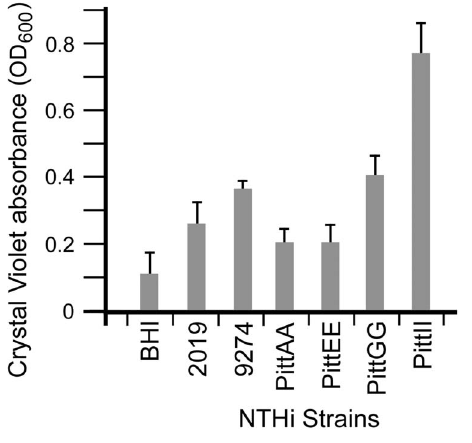
Figure 1. Biofilm formation is variable between NTHi strains. Biofilm quantification using crystal violet assay showed the variability in biofilm formation between the NTHi strains in this study. Relative Biofilm Quantity was measured as OD 600 of crystal violet in DMSO; higher absorbance indicated more biofilm production. The PittAA and PittEE strains showed the least amount of biofilm attachment to the growth surface while PittII showed the most. The other three strains (2019, 9274 and PittGG) formed intermediate amounts of biofilm material (t-test analysis in Table S2).